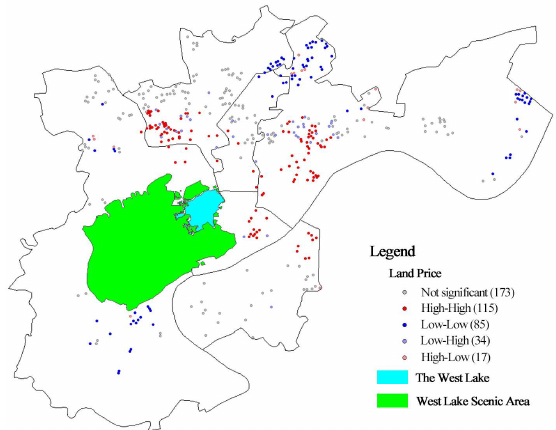
Figure 7. Lisa Cluster Map.